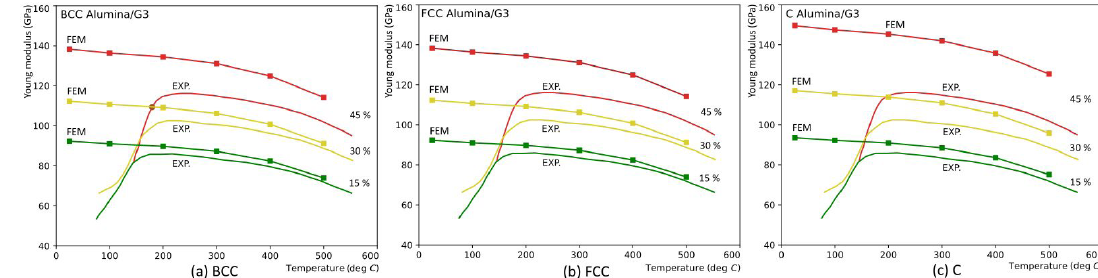
Figure 10. Young modulus obtained for Alumina/G3 composites.